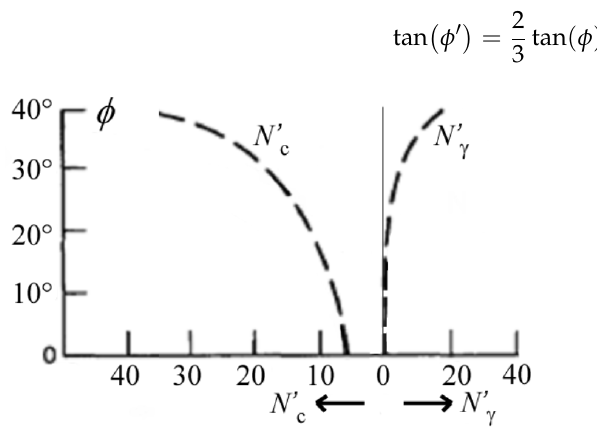
Figure 8. Terzaghi’s modified bearing capacity factors.